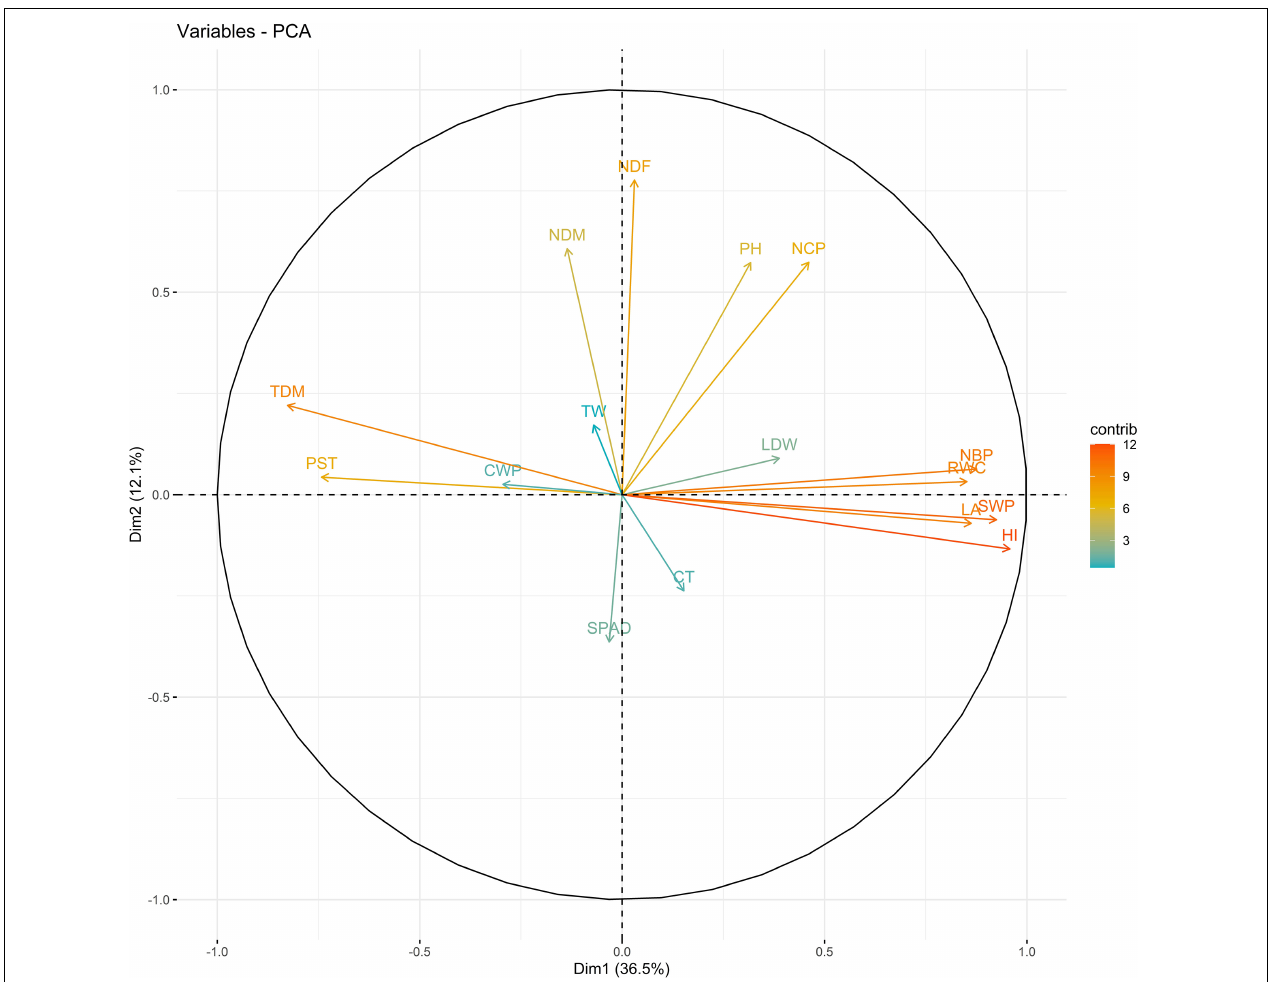
FIGURE 1 | Biplot between PC1 and PC2 showing contribution of various traits during year 2018 season under well-watered (WW) conditions.